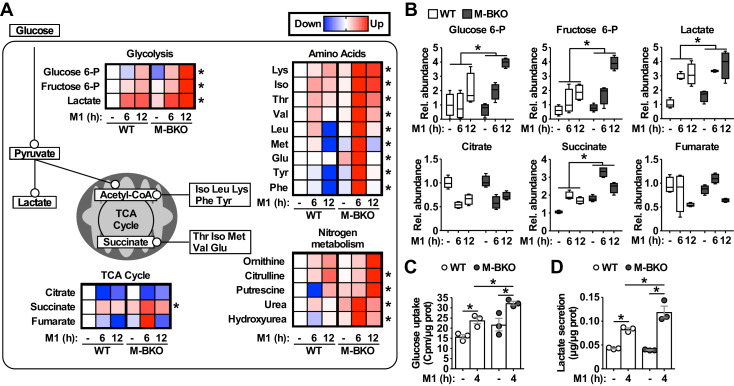
Bmal1 deletion induces a metabolic shift for glycolytic and amino-acid metabolism.(A) Summary of steady-state metabolomics data for differentially regulated metabolites from WT and M-BKO macrophages throughout a 12-hour M1 activation time course. Data are presented as heat maps (normalized to WT control for each metabolite, each panel is the average of four biological replicates). Statistical analysis was performed using two-way ANOVA for WT vs M-BKO across the time course. (B) Box plots of the relative abundances of select metabolites in panel (A). (C, D) Uptake of [3H]−2-deoxyglucose (C) and lactate secretion (D) in control or M1-activated macrophages. N = 3 biological replicates, statistical analysis was performed using Student’s T test. Cell culture assays were repeated at least twice.Figure 3—source data 1.Metabolomics data for M1-activated WT and M-BKO macrophages.